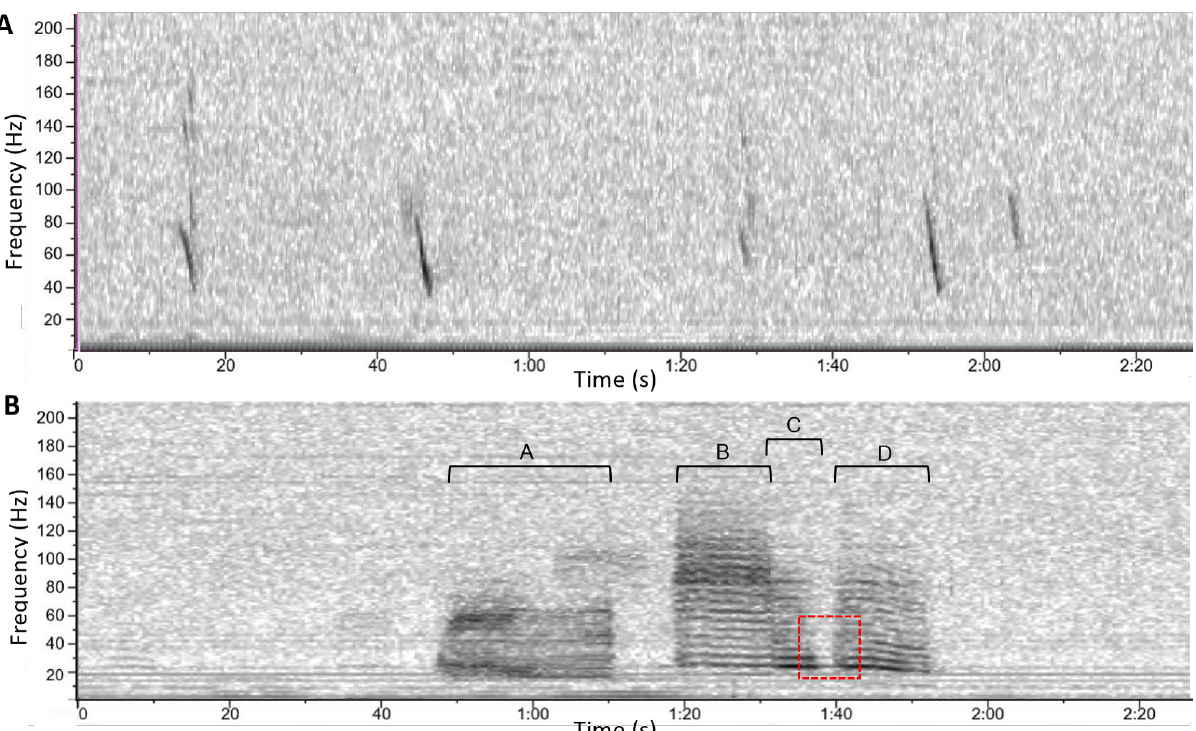
Figure 1. Spectrogram of a series of high-quality D calls ( A ) and a SEP2 call ( B ) from this study. SEP call units are marked by A, B, C, D. The red box indicates the portion of the call with higher SNR used to detect fainter calls (see Section 2.1 in the Materials and Methods). Spectrogram parameters: 200 Hz frequency axis, DFT = 2048 samples, FFT = 750, 10% overlap and Hann window function. Spectrograms produced with Raven Pro